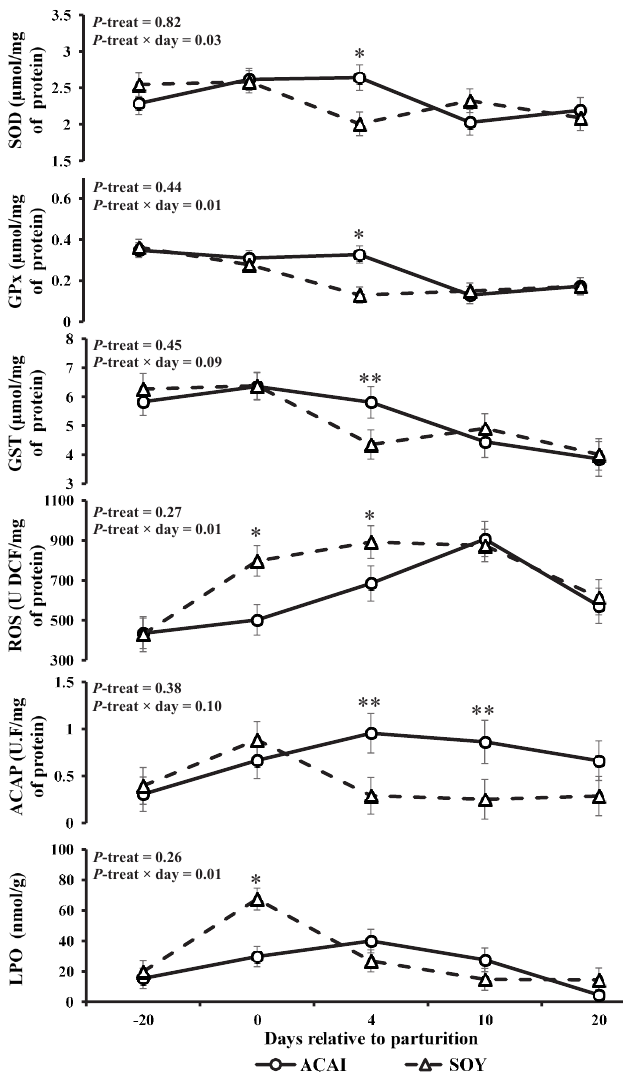
Figure 1. Serum levels of superoxide dismutase (SOD), glutathione peroxidase (GPx), glutathione transferase (GST), reactive oxygen species (ROS) total antioxidant capacity against peroxyl radicals (ACAP) and lipoperoxidation (LPO) of cows fed with açai oil or soybean oil during the prepartum period: analyzes made in the pre- and postpartum (20 days prepartum, day of partum, and 4, 10, 20 postpartum). The treatments AÇAI and SOY represents 4% of açai or soybean oil in the diet, respectively. Differs (*; P ≤ 0.05) or tends to differ